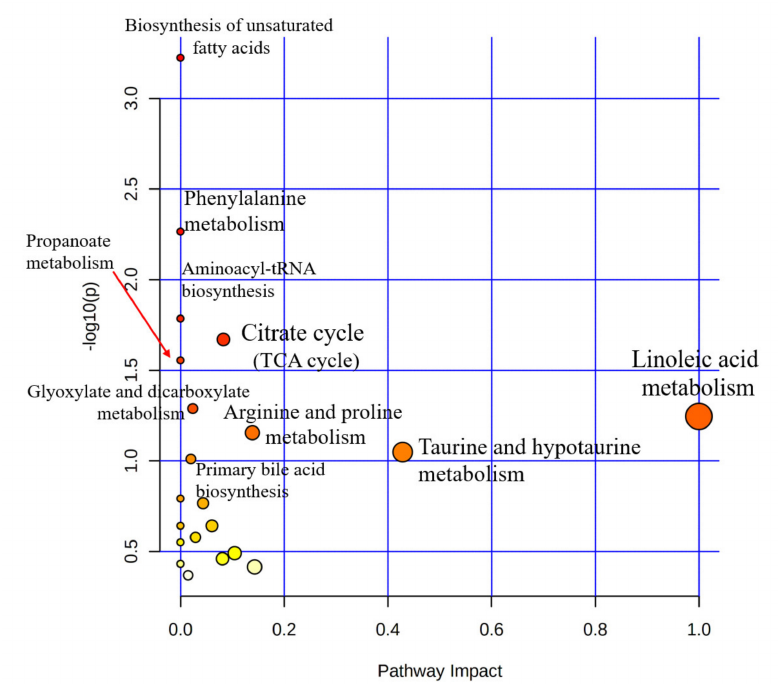
Figure 5. Pathway analysis of the altered metabolites in plasma.